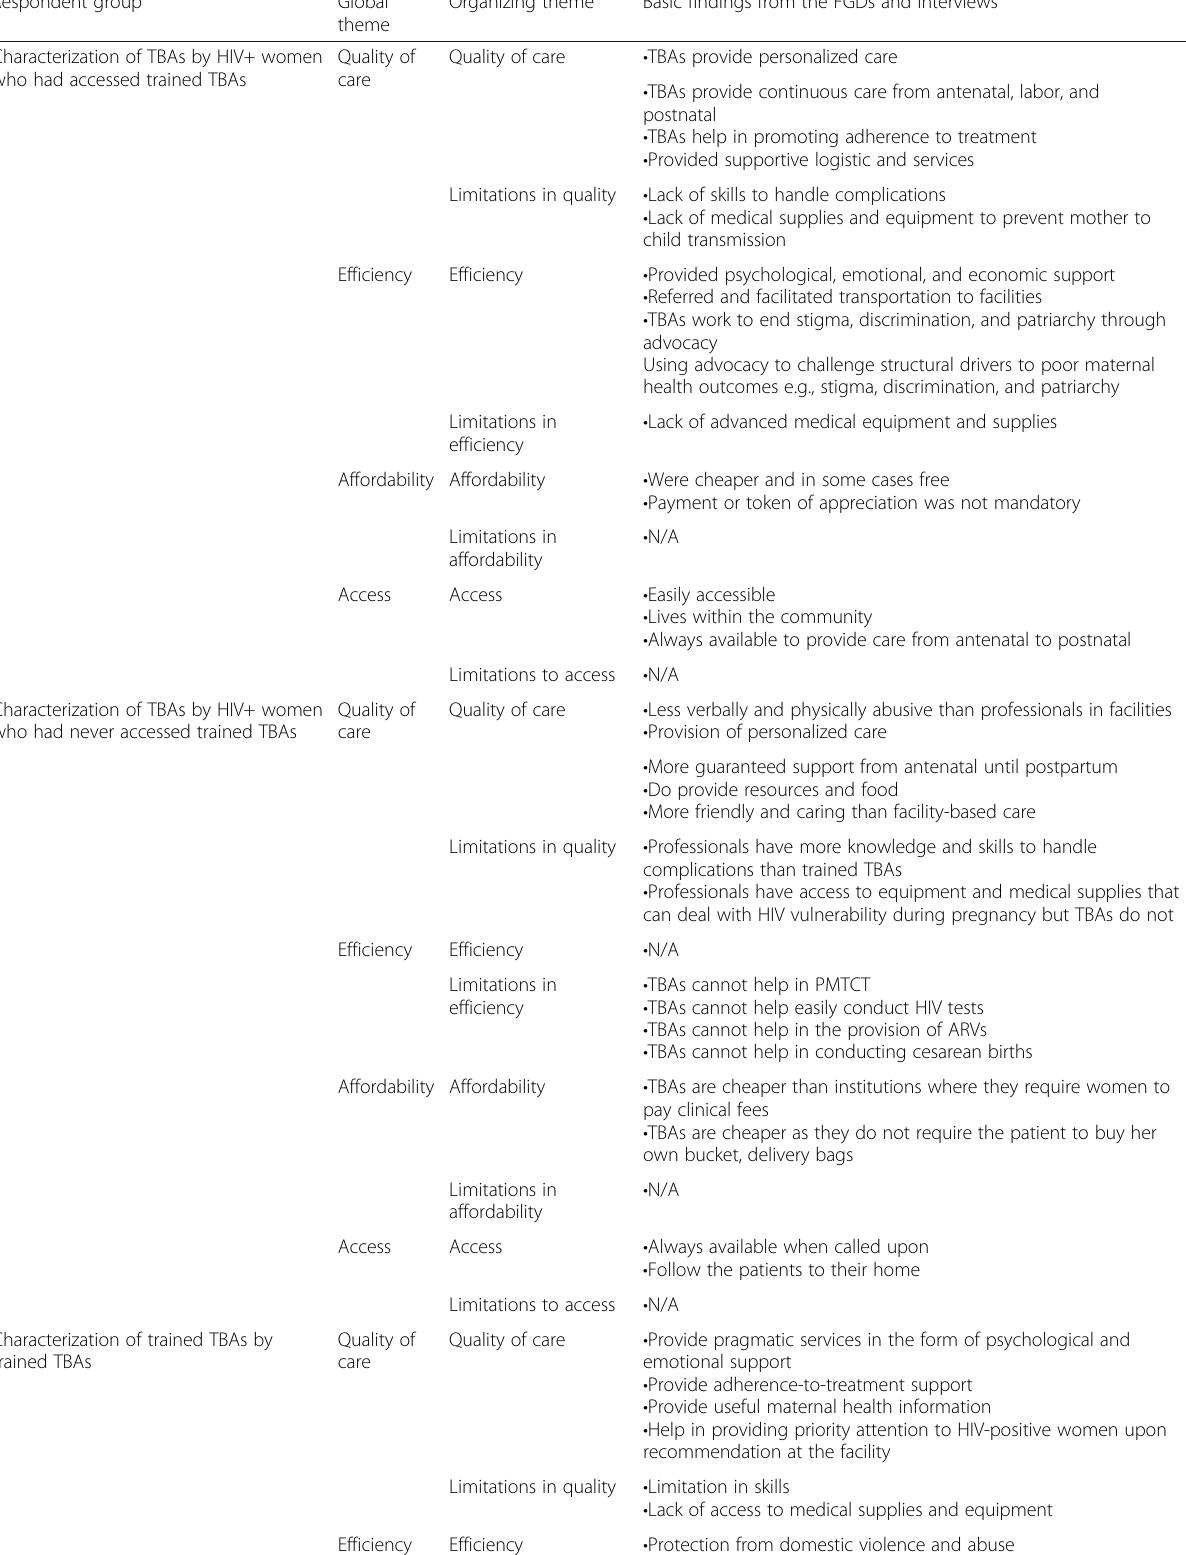
Table 2 Summary of qualitative